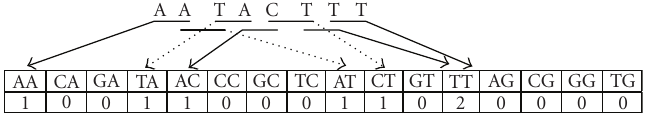
Figure 2: Dinucleotide frequency counting for the short sequence “AATACTTT.”